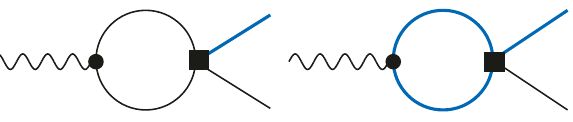
Figure 2 . The Feynman diagrams contributing to the non-trivial analyticity properties of the form factors W + ;S ;1L ( z ) at one loop. The external wiggly line corresponds to the insertion of the electromagnetic current j (cid:22) ( x ). Thin lines represent charged pions, and thicker blue lines are kaons (only charged kaons contribute in the loop). The circular blob stands for a strong vertex, and the (cid:12)lled square for the weak